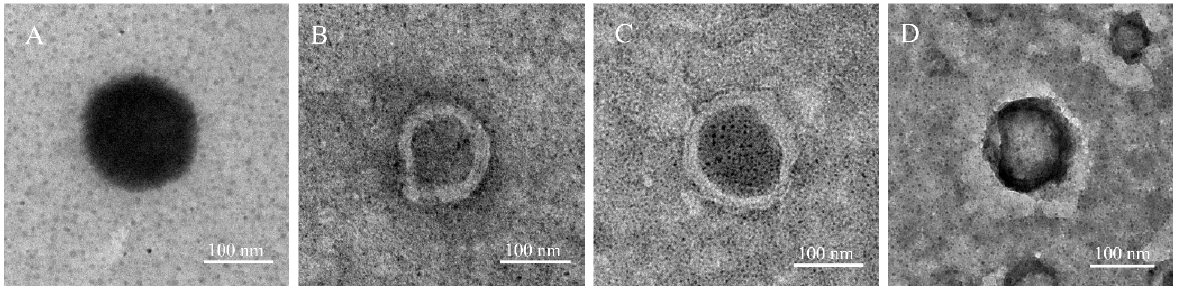
Figure 5. Representative TEM images of liposomes and SF-LPs with different SF concentrations. ( A ) Uncoated liposomes and SF-LPs when using ( B ) SF 0.5%, ( C ) SF 1.0%, and ( D ) SF 2.0%. In the presence of SF, a multilayer appearance was observed on the surface of liposomes.